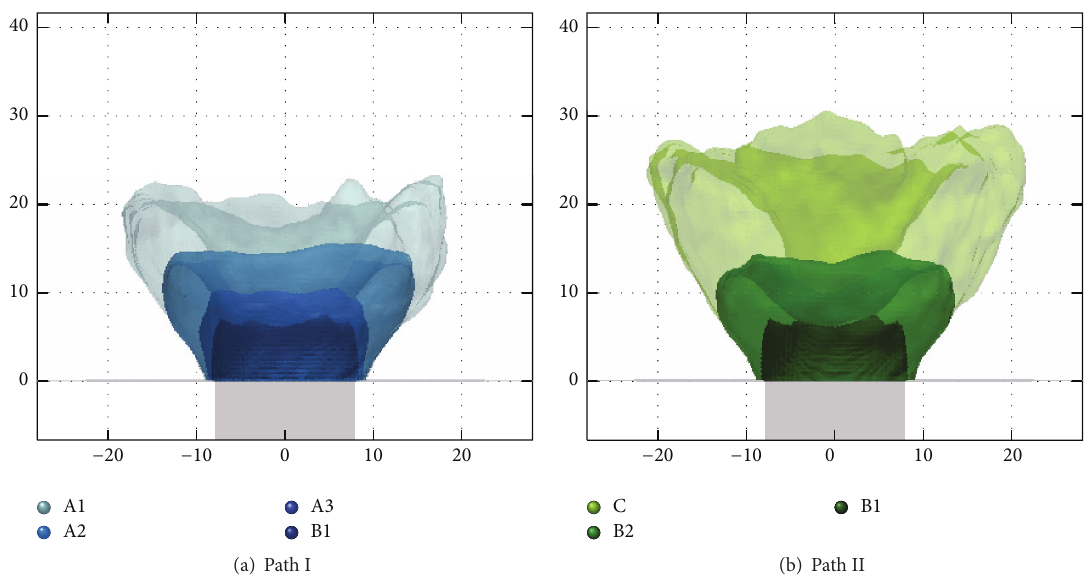
Figure 7: Superposition of flame surfaces in a scaled